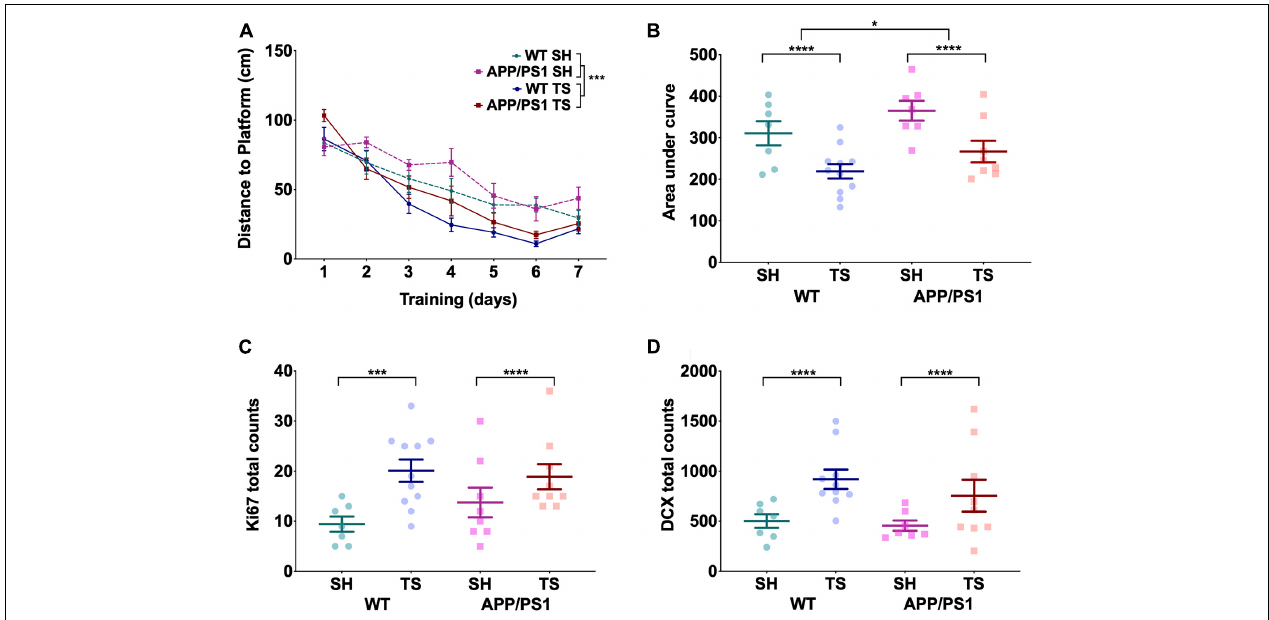
FIGURE 4 | Touchscreen training improved cognitive ability in the MWM and increased the number of immature neurons and proliferating cells in the dentate gyrus. (A) The average distance to platform of the 7 days of MWM training. A significant decrease in distance was seen over the days, with touchscreen-trained animals showing significantly shorter distances to platform regardless of genotype. (B) Touchscreen tested (TS) animals showed a significantly smaller area under the curve of the 7 days of MWM training, while APP/PS1 mice showed significantly larger AUC than their WT counterparts. (C) Total count of Ki67 + cells seen throughout the dentate gyrus, with no effect of genotype but TS tested animals showed significantly more Ki67 + cells than standard housed (SH) animals. (D) Total count of DCX + cells seen throughout the dentate gyrus, where TS mice showed significantly more DCX + cells than SH animals and genotype had no effect. (A) Is presented as mean ± SEM with the average distance for each group on a given day shown as a dot. (B–D) Are presented as mean ± SEM with individual animals as dots. * p < 0.05; *** p < 0.001; **** p <